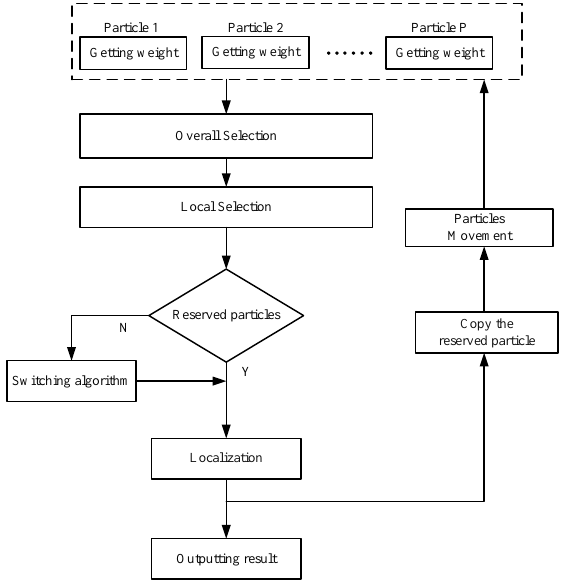
Figure 3. Flow chart of the proposed algorithm.